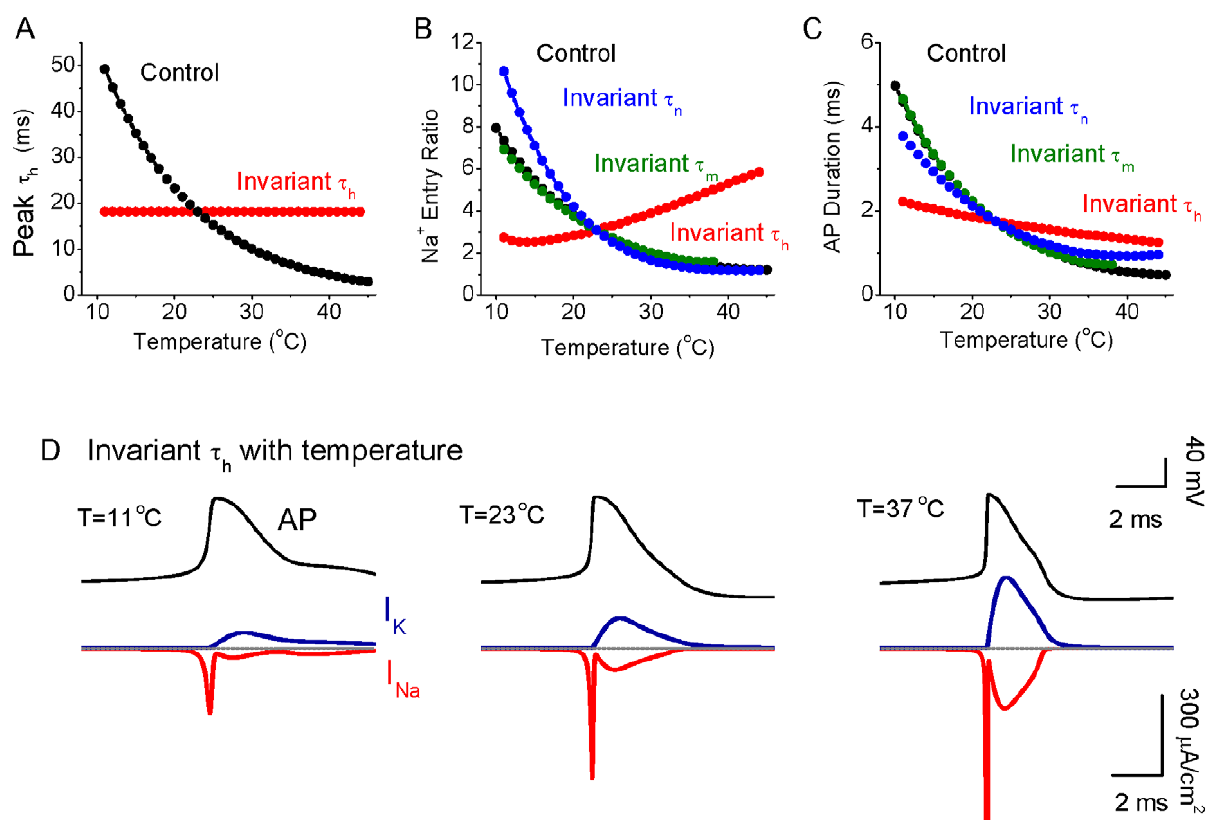
Figure 5. Contribution of changes in Na + and K + channel time constants on the effects of temperature on spike efficiency and duration. A. The maximum of Na + inactivation time constant t h decreases as temperature increases for the normal model (control; black). For the test group, the maximum of Na + inactivation time constant t h is invariant with temperature change (red). B. The Na + entry ratio decreases as a function of temperature for control (black), while the Na + entry ratio increases as a function of temperature when the inactivation time constant of I Na ( t h ) is fixed. Keeping I Na activation time constant ( t m ) invariant or I K activation time constant ( t n ) invariant with temperature reveals effects of temperature on Na + excess entry similar to that in control. C. The half-height spike duration decreases as a function of temperature for the control group (black), while it becomes relatively independent to temperature change when I Na inactivation time constant, t h , is invariant. The test group with invariant t m , or t n , has similar behavior as that in control group. D. Example membrane potential and I Na , I K for 11, 23, and 37 u C when the time constant of I Na inactivation ( t h ) is kept constant. Note that the overlap of Na + and K + currents becomes larger with temperature, which is opposite to the normal situation (see Figure